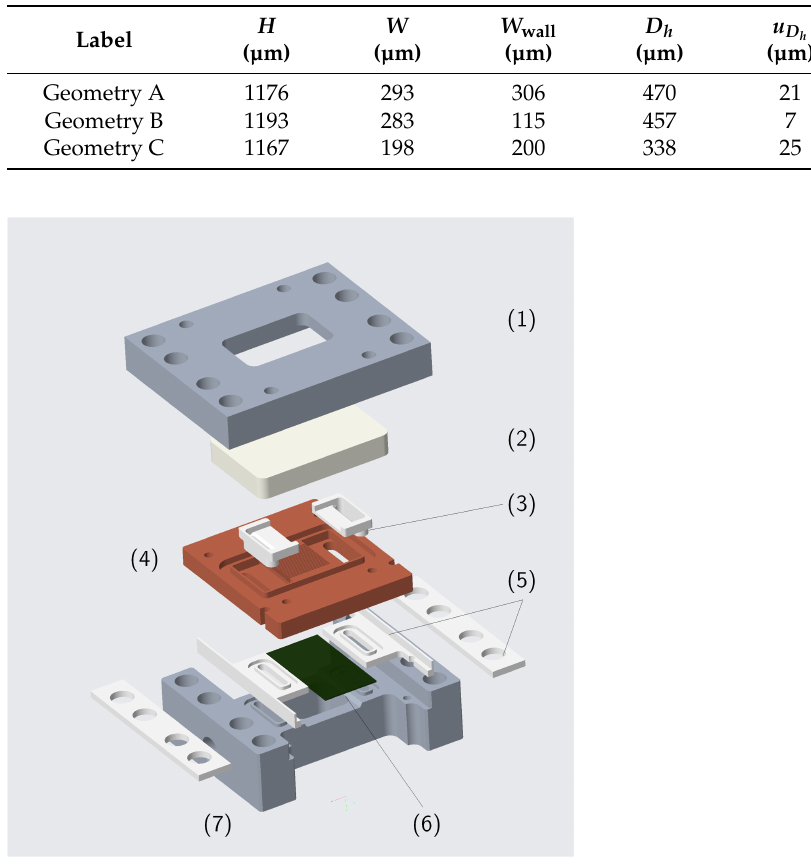
Figure 2. Exploded view of the test section: (1) steel cover, (2) cover glass, (3) PEEK (PolyEther Ether Ketone) manifold inserts, (4) copper heat sink with microchannels, (5) insulating PEEK inserts, (6) serpentine heater, and (7) steel